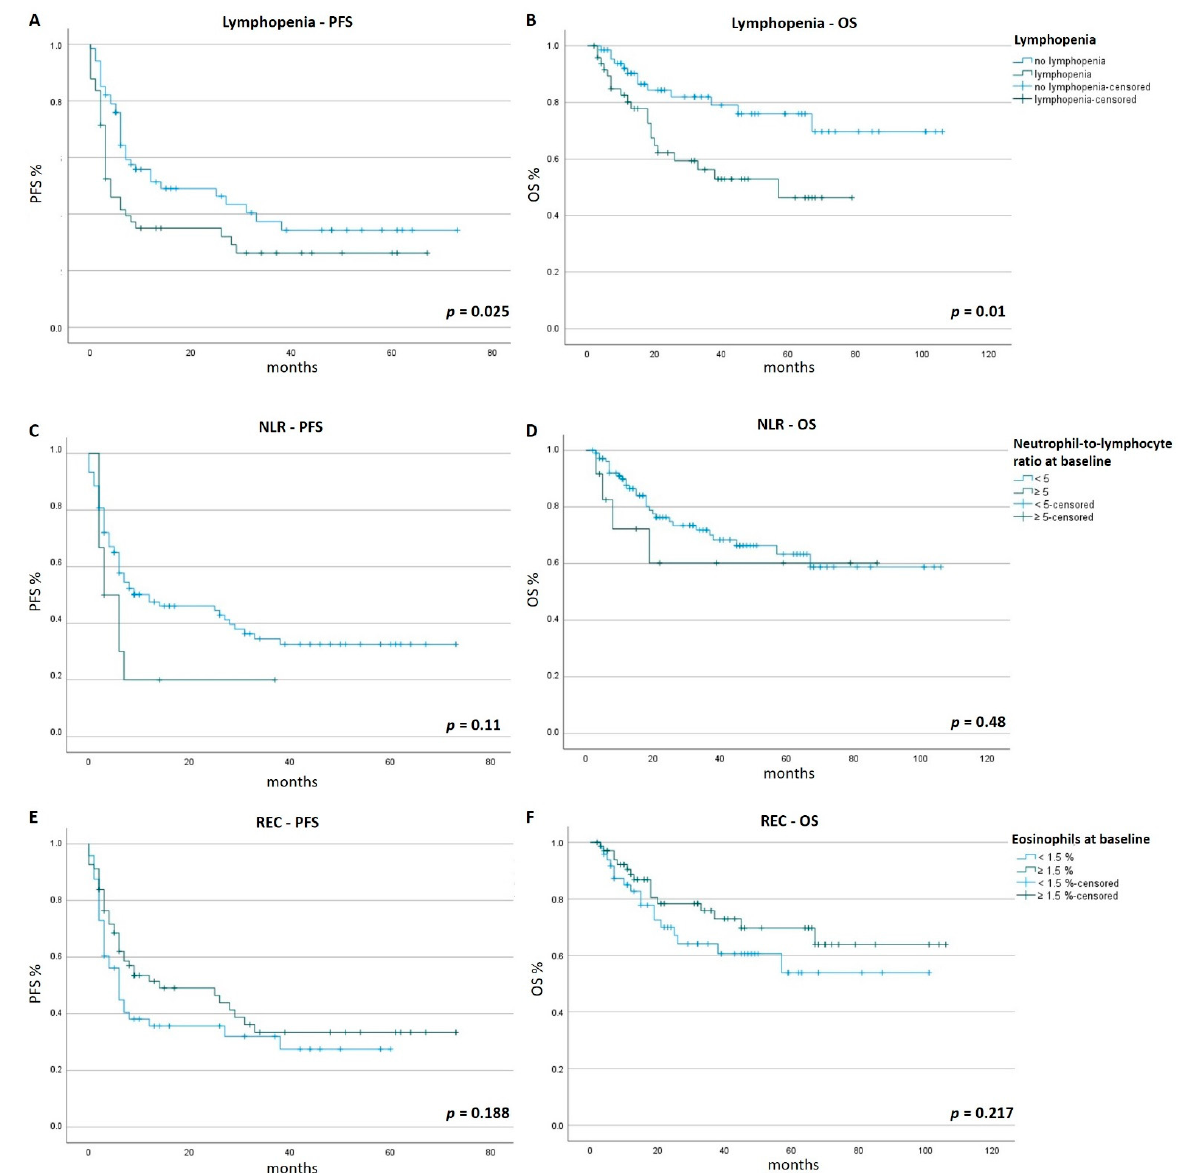
Figure 1. PFS and OS. Patients were followed for a minimum of 6 months. Tick marks indicate censored data. Time is given in months. Panels ( A , C , E ) show the Kaplan–Meier estimates of PFS of patients. Panels ( B , D , F ) show the Kaplan–Meier estimates of OS. Panel ( A ): the mean PFS of patients who developed lymphopenia was significantly shorter (13.3 months) compared to patients who did not develop lymphopenia (16.9 months, p = 0.025). Panel ( B ): the mean OS of patients who developed lymphopenia was significantly shorter (28.1 months) compared to patients who did not develop lymphopenia (36.8 months, p = 0.01). Panel ( C ): the mean PFS of patients with a NLR ≥ 5 at baseline was longer (16.3 months) compared to patients with a NLR < 5 at baseline (7.3 months, p = 0.11). Panel ( D ): the mean OS of patients with a NLR ≥ 5 at baseline was longer (33.6 months) compared to patients with a NLR ratio < 5 at baseline (28.8 months, p = 0.48). Panel ( E ): the mean PFS of patients with a relative eosinophilic count (REC) ≥ 1.5% at baseline was longer (16.9 months) compared to patients with a REC < 1.5% at baseline (13.3 months, p = 0.188). Panel ( F ): the mean OS of patients with a REC ≥ 1.5% at baseline was longer (34.2 months) compared to patients with a REC < 1.5% at baseline (31.6 months, p =